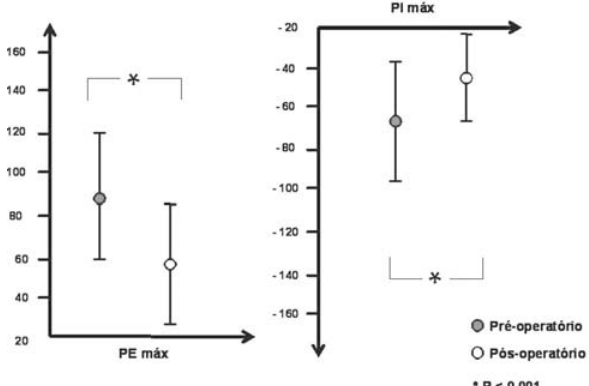
Fig. 3 - Comparação dos valores de pressão expiratória e inspiratória